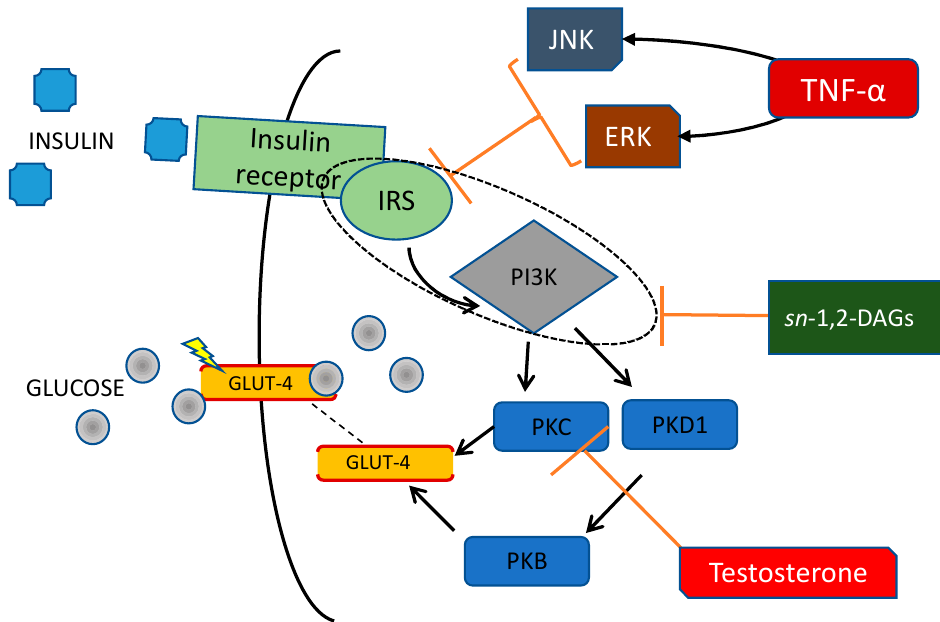
Figure 2. Alterations in the insulin receptor pathway, resulting from the activity of pro-inflammatory cytokines and androgens. Tumour necrosis factor α (TNF- α ) affects insulin signaling by phosphorylation of serine in insulin receptor substrate-1 (IRS-1) through activation of several serine kinases, including c-Jun-NH2-terminal kinase (JNK) and extracellular signal-regulated kinase (ERK). It inhibits insulin-induced tyrosine phosphorylation of IRS-1 and downregulates phosphoinositide 3-kinase (PI3K) activity. Decreased adiponectin concentration results in increased membrane sn-1,2-diacylglycerols (sn-1,2-DAGs) activity. It leads to impaired kinases activity and decreased insulin signaling. Testosterone induces insulin resistance in cells by affecting insulin-stimulated phosphorylation of protein kinase C (PKC). All these mechanisms contribute to decreased glucose transporter type 4 (GLUT-4) expression and decreased glucose transport into cells.